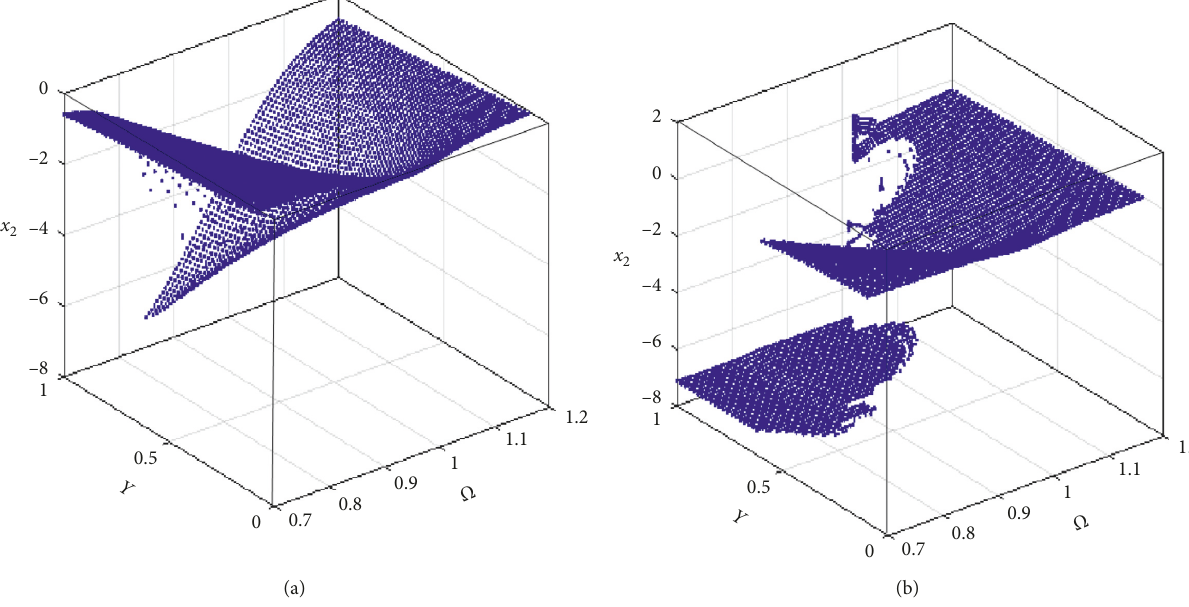
Figure 11: Bifurcation diagrams of the baseplate (with Ω and Y as control parameters) for different surface topographies: (a) n � 1.046; (b) n � 2.333.